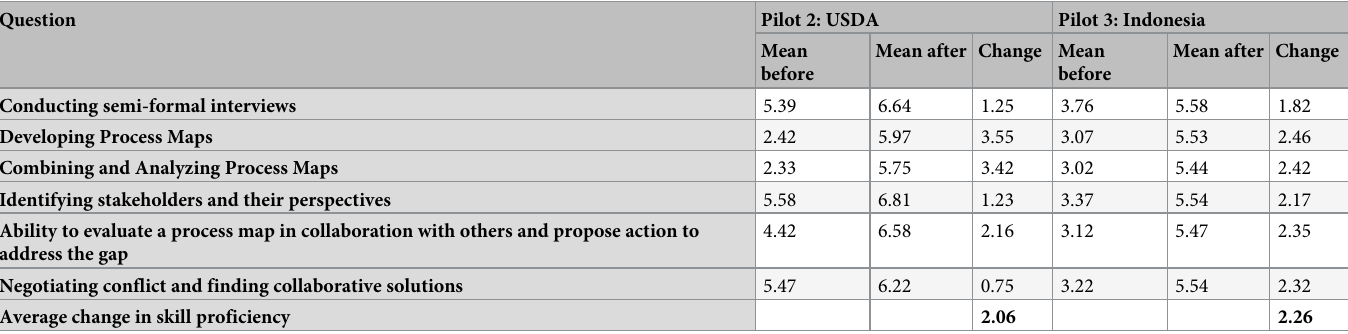
Table 4. Participant skill proficiency. Workshop participant skill proficiency performance before and after pilot 2: USDA (N = 36) and pilot 3: Indonesia (N = 87) on a scale from 0–7, zero being not at all proficient and seven being extremely